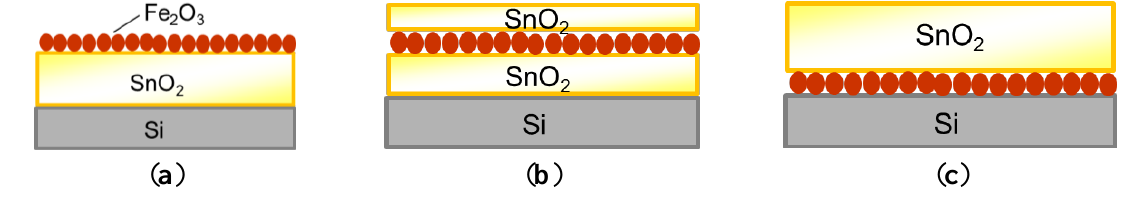
Figure 12. Catalyst structures formed in this study: ( a ) Fe 2 O 3 /SnO 2 ; ( b ) SnO 2 /Fe 2 O 3 /SnO 2 ; and ( c ) SnO 2 /Fe 2 O 3 structures.